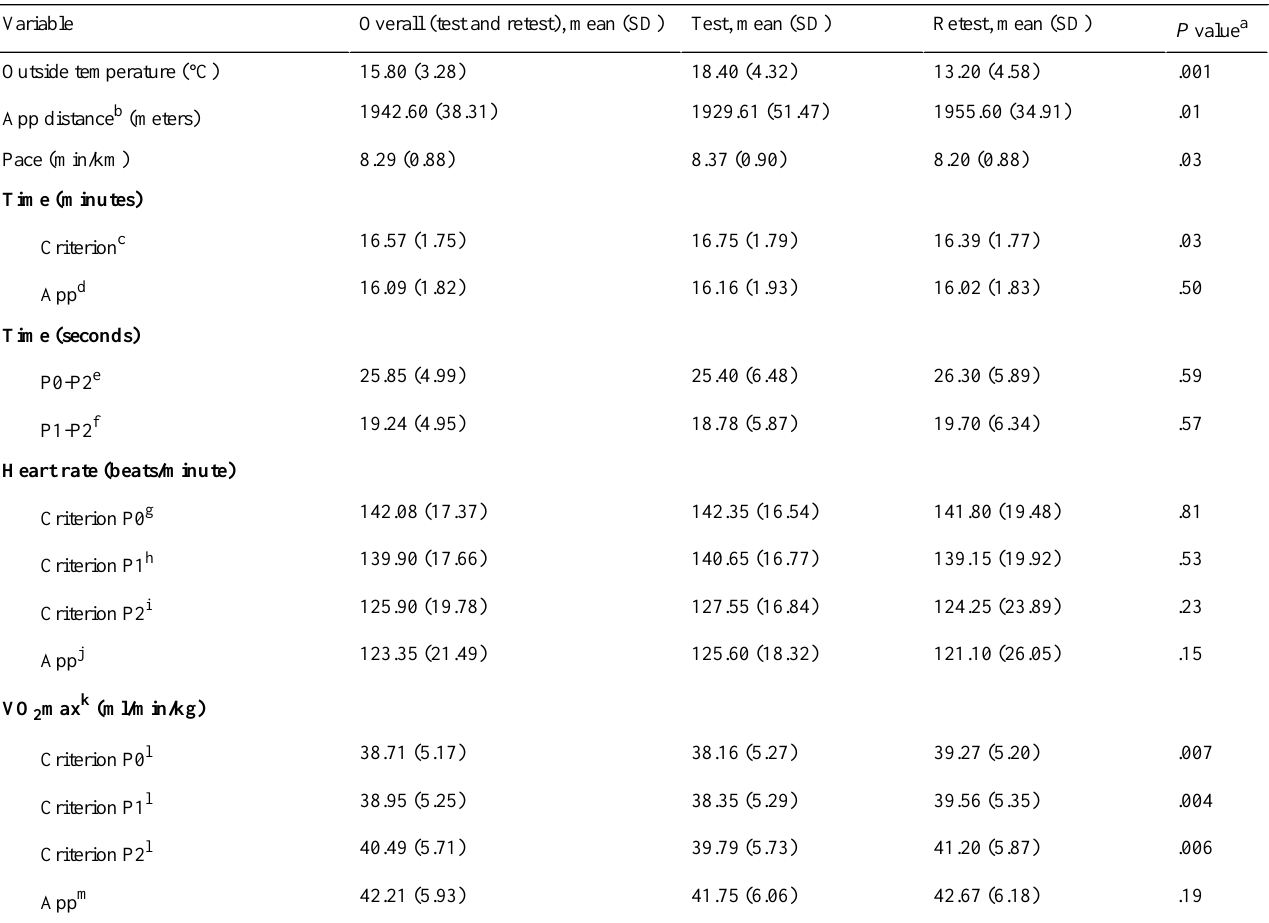
Table 2. Test and retest results of the 2-km walk UKK test